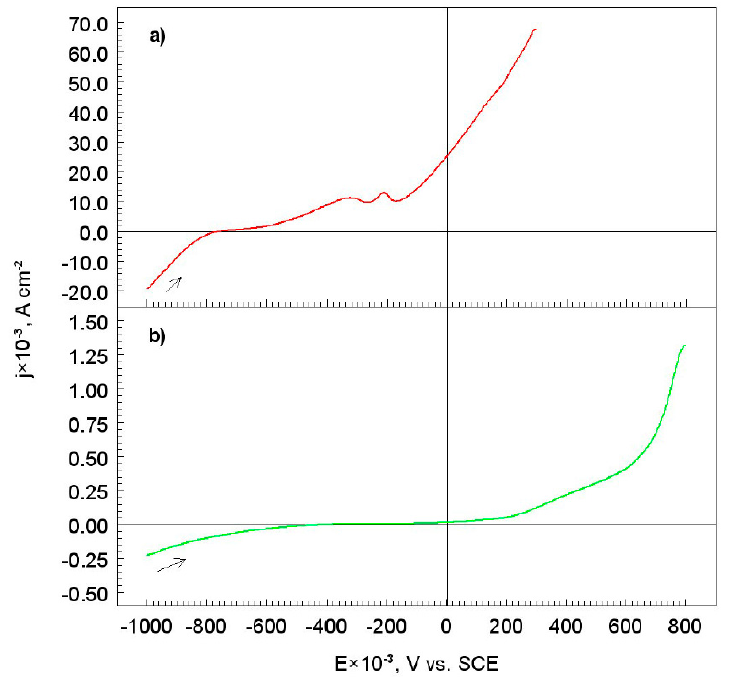
Figure 4. Potentiodynamic polarization curves for: ( a ) S355 steel and ( b ) S355 steel with DLC coating. The solution contained 1.2 M Cl − and 0.2 M OH − , dE/dt 1 mV s − 1 , at a temperature of 25 °C.